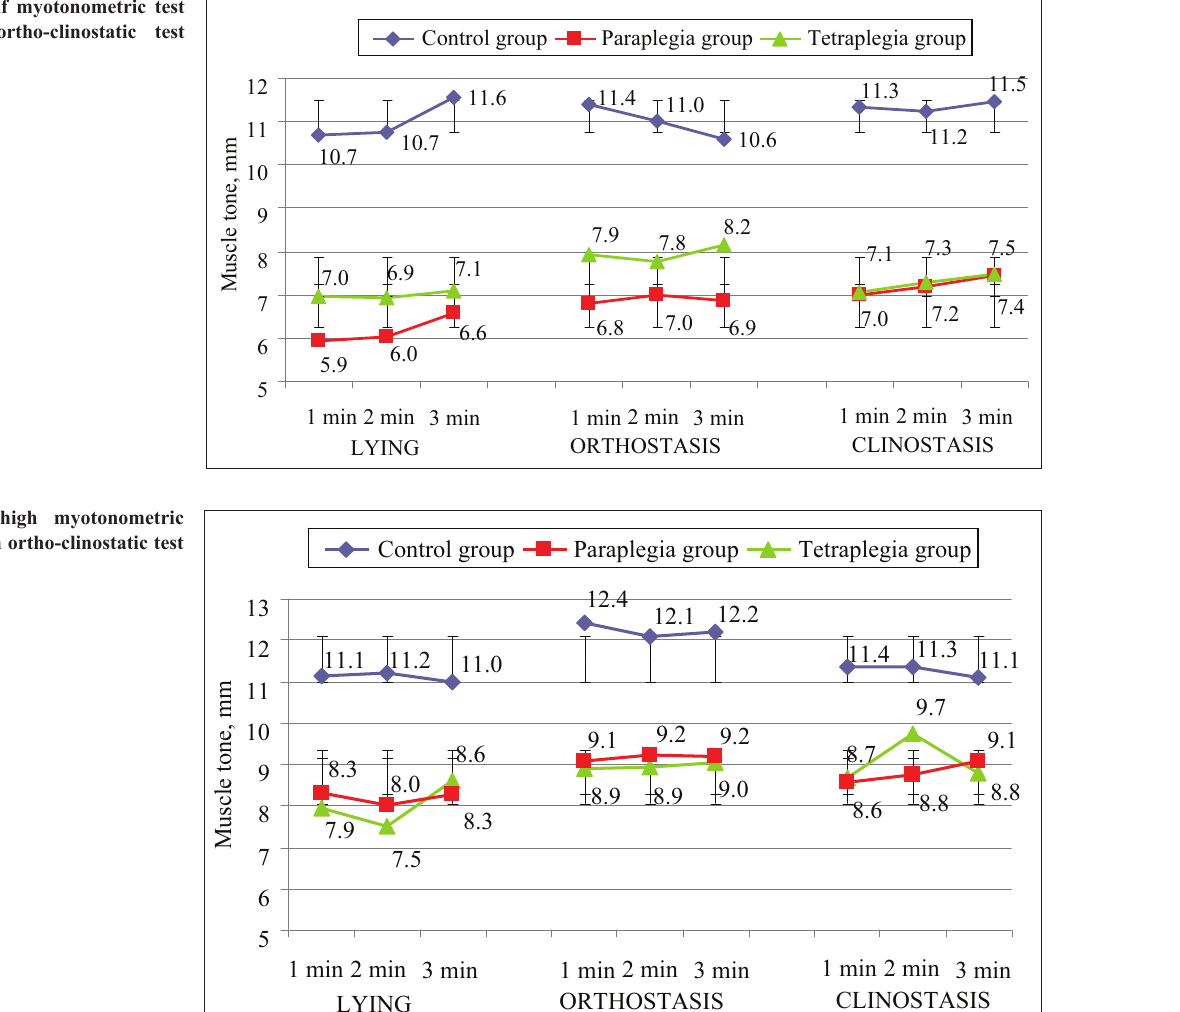
Figure 3. Calf myotonometric test results in ortho‑clinostatic test (averages)